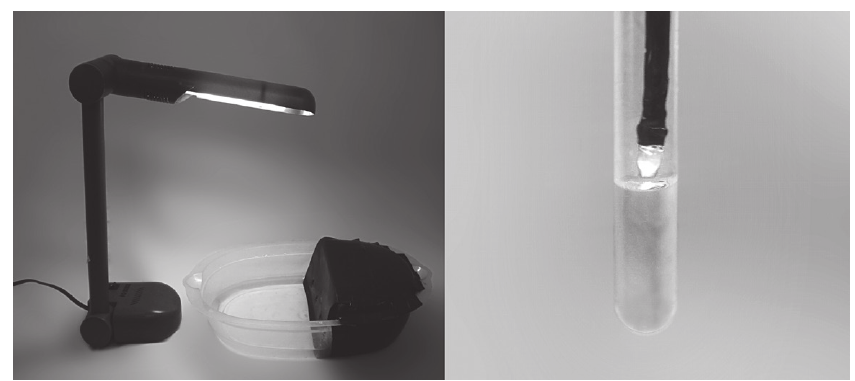
Figure 2 - (A) Container used for hatching brine shrimp; (B) Tube containing A. salina microcrustaceans and RBB aqueous solution irradiated with